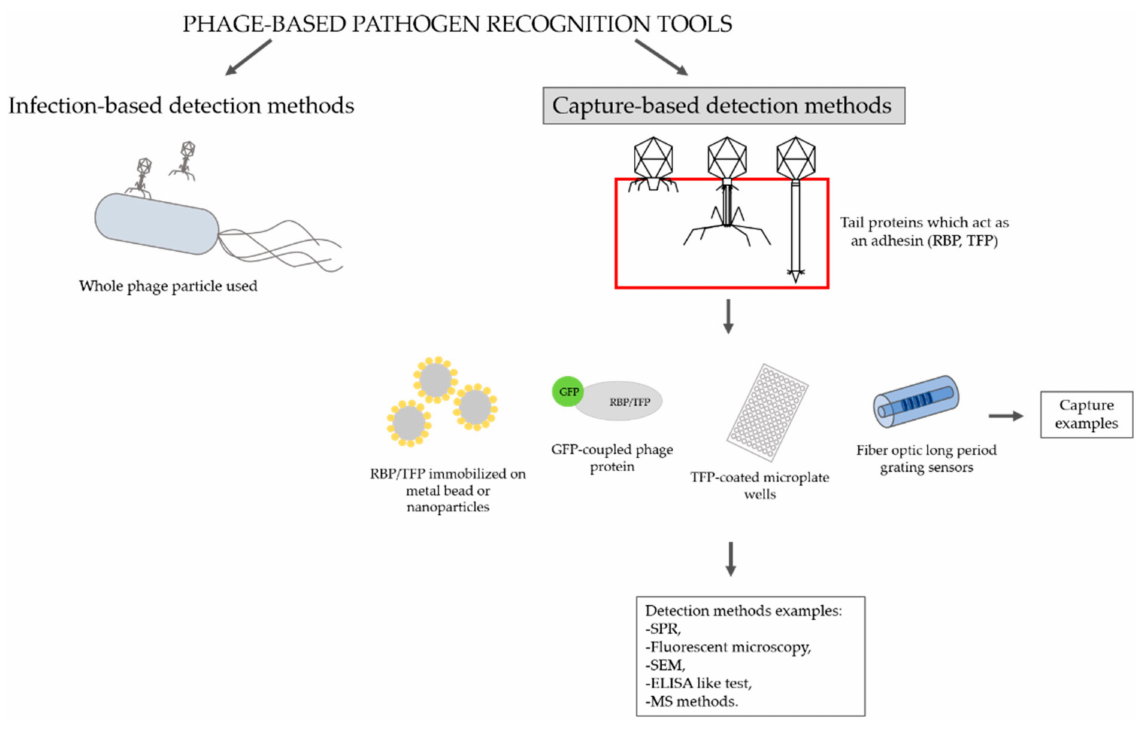
Figure 2. Phage-based pathogen recognition tools. SPR—surface plasmon resonance; SEM—scanning electron microscopy; ELISA—enzyme-linked immunosorbent assay; MS—mass